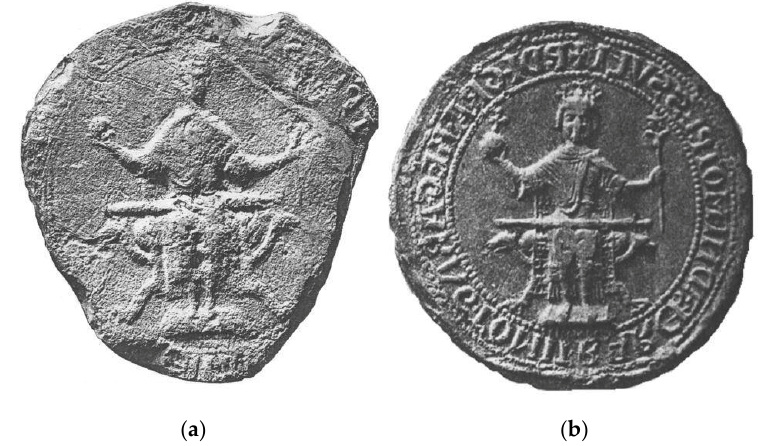
Figure 1. ( a ) Main seal of Peter III, obverse. 1206. From (De Sagarra i Siscar 1916–1932, n. 9). ( b ) Bull of Peter II, obverse. 1210 (ibid., n. 13). Both seals show the first use of the globe in the sigillography of the king of Aragon. Used with permission according with publishing rules in